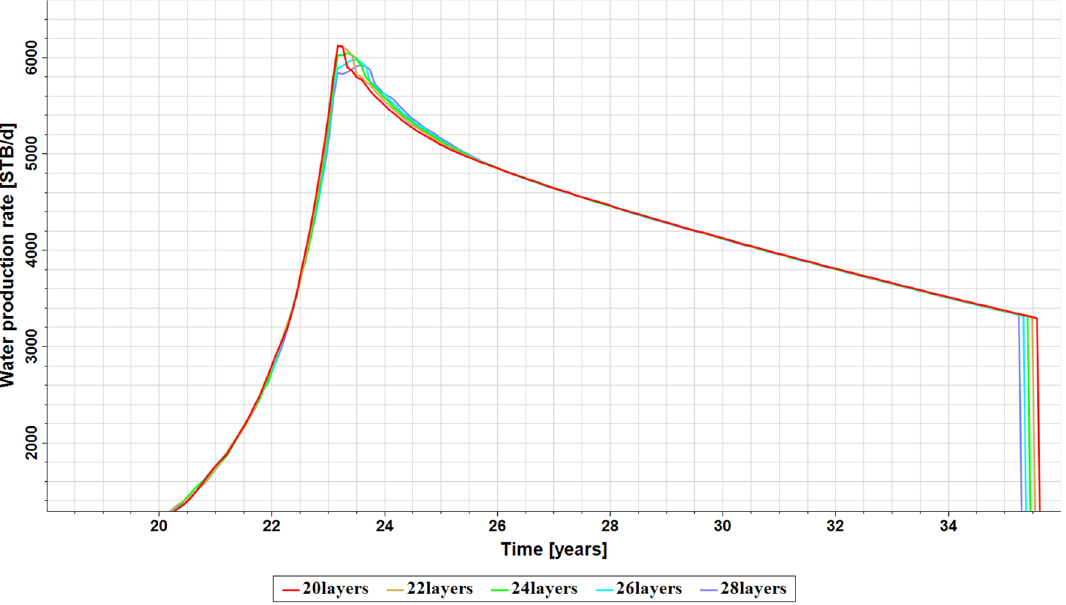
Fig. 16 Water production rate for models with 20–28 layers